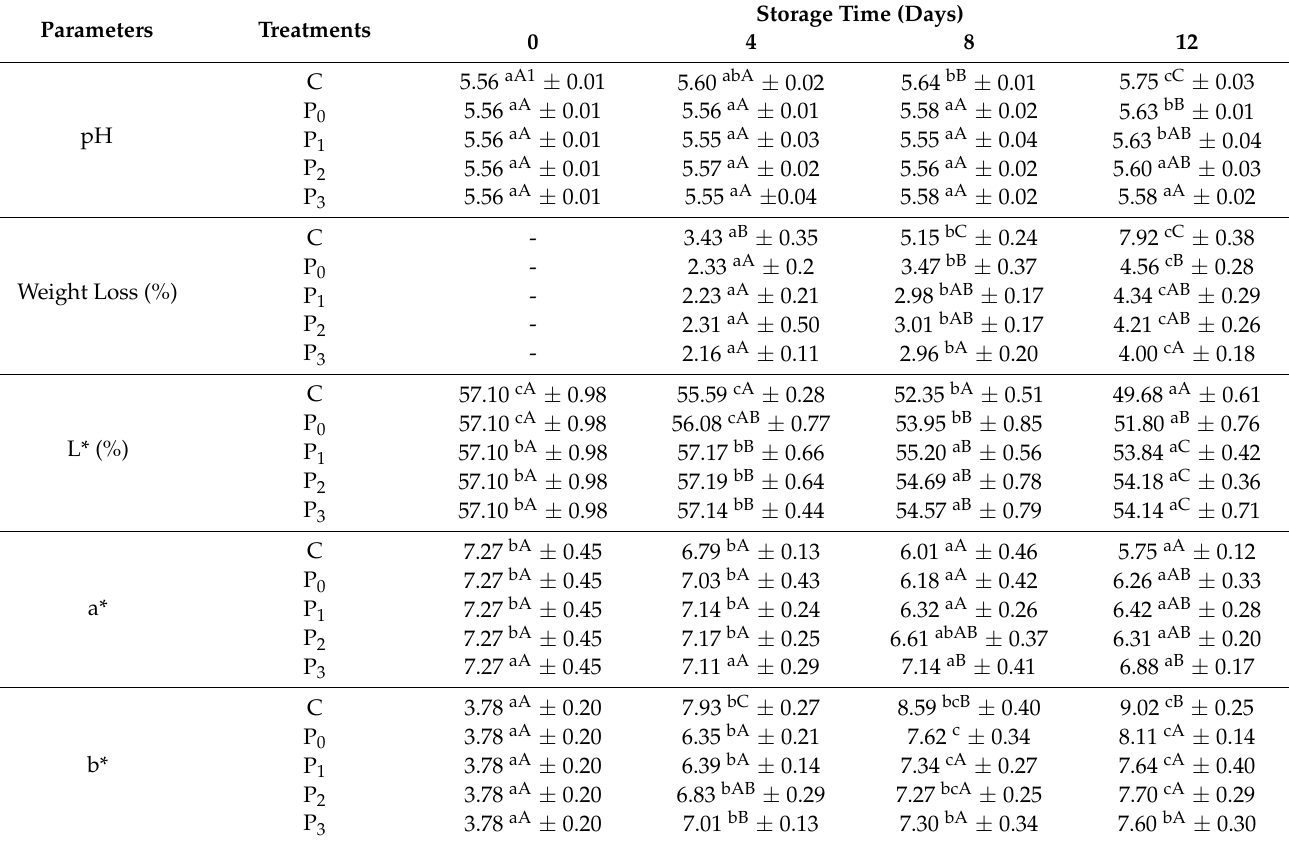
Table 2. Effect of the applied coatings on the physical parameters of pork loins during storage.